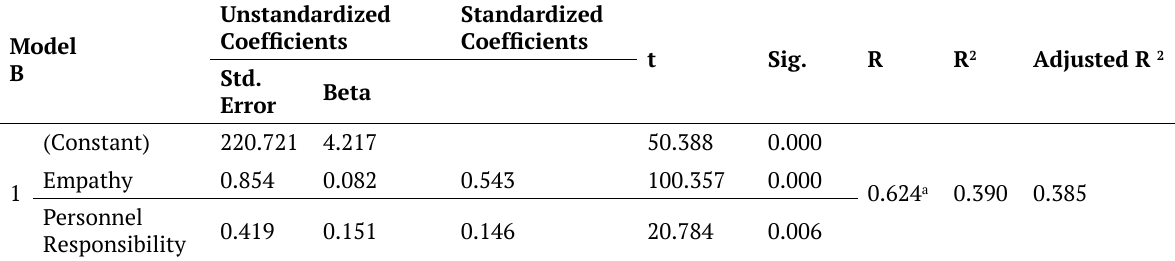
Table 4. Simple linear regression analysis showing predictive power of independent variables